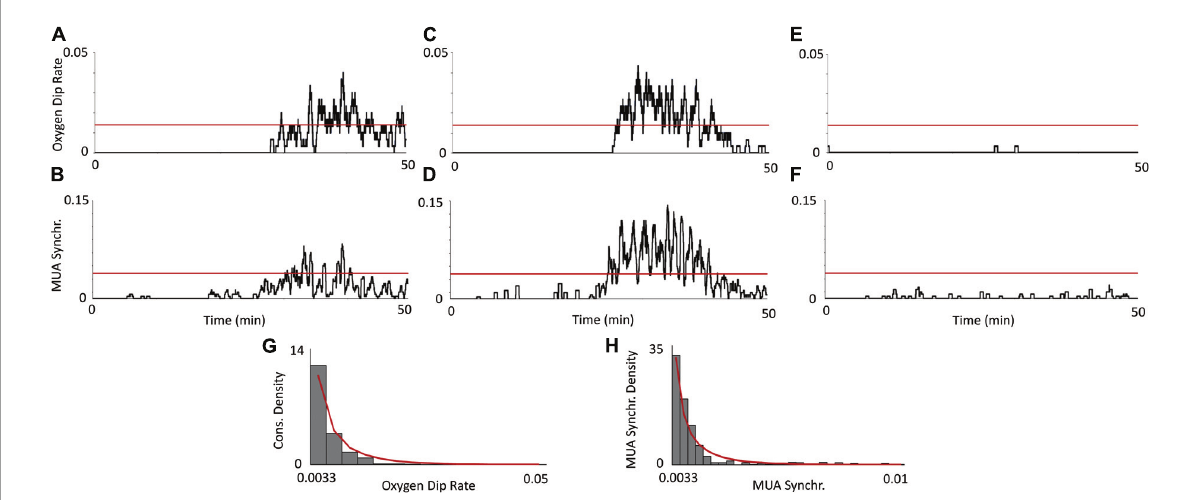
FIGURE3 Relationship between oxygen consumption and neuronal synchronization. Using the same two PTX experiments from Figure 2 , a plot of the consumption rate measure (A,C) , shows a significant increase in PO 2 consumption past the 30 s mark. This increase in PO 2 consumption corresponds with an increase in MUA activity (B,D) , indicating that the consumption spikes are indeed due to an increase in aggregate neuronal activity. The oxygen dip rate and MUA synchronization measure show no statistically significant deviations [ (E,F) , respectively], indicating that this consumption activity does not occur in the control. The red, horizontal line denotes the threshold value (for each respective measure) at a 1% level of significance, calculated from the distribution of saline experiments. The density plot of the oxygen dip rate and MUA synchronization measures over all saline experiments ( N = 7) is plotted [ (G,H) , respectively]. The bars denote data from our actual recorded control experiments and the red line denotes the best-fit beta